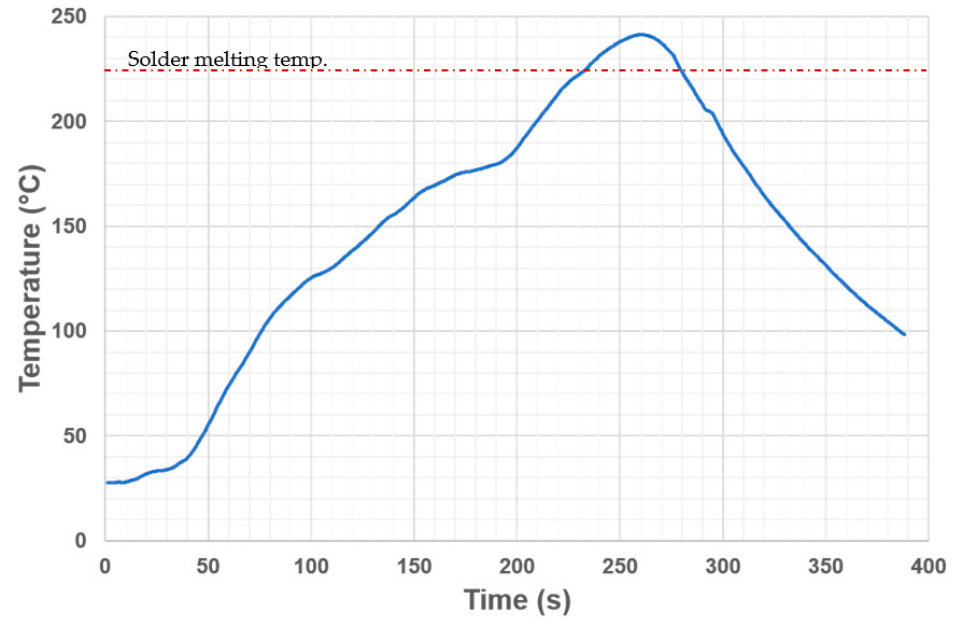
Figure 3. The temperature profile of the reflow oven used for sample